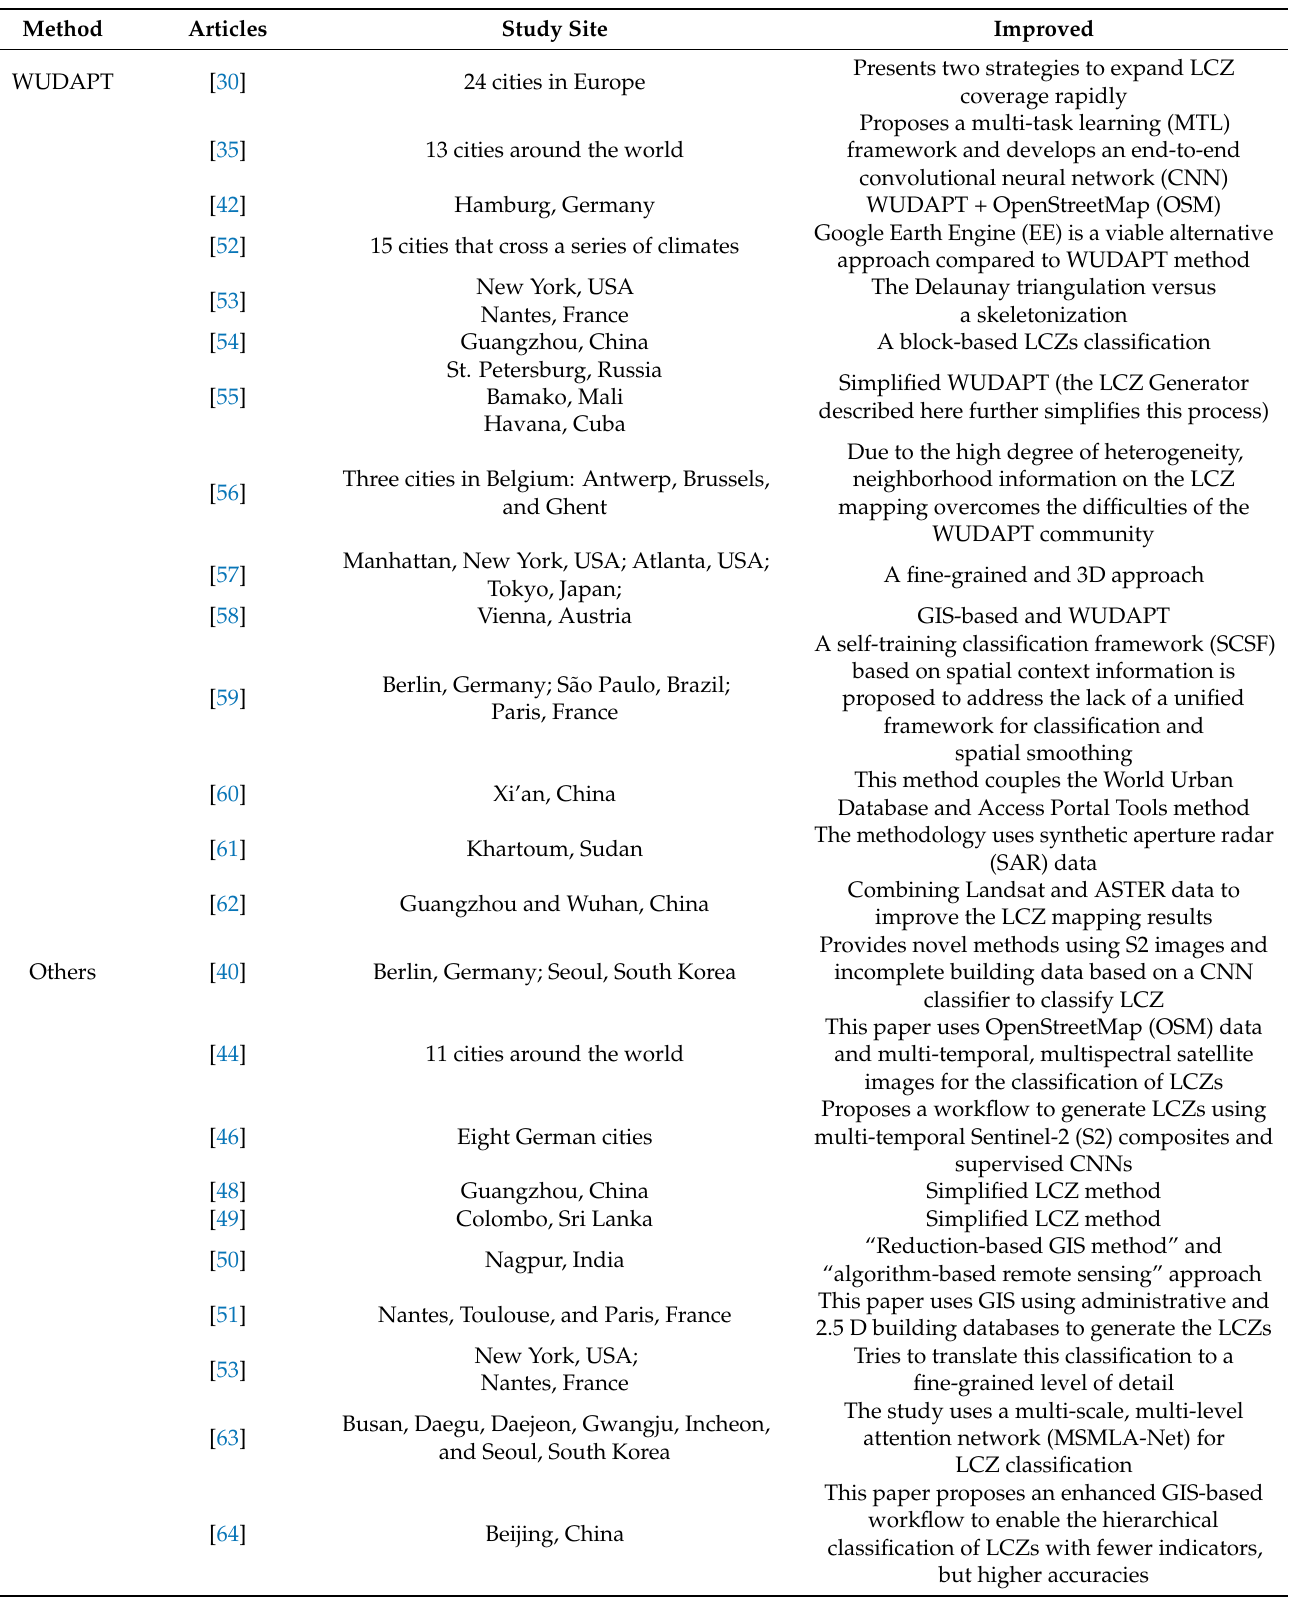
Table 4. LCZ mapping improvement